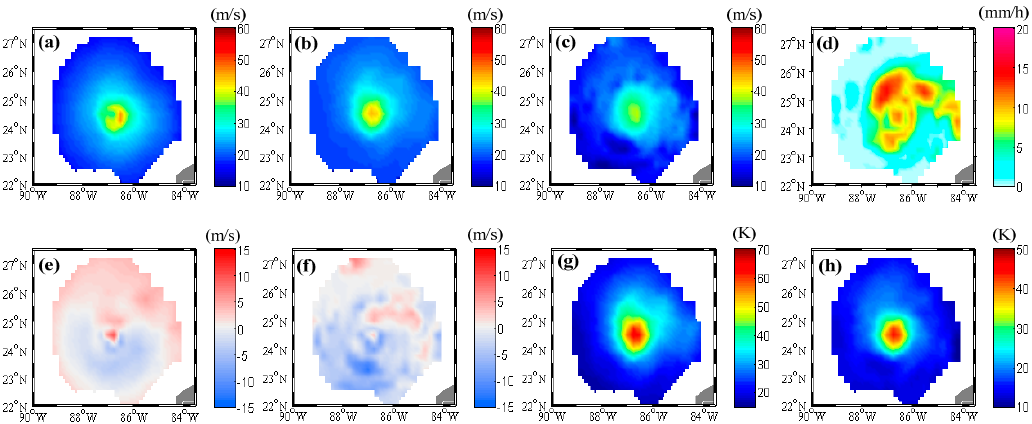
Figure 11. ( a ) H*wind wind speed for Rita on 22 September 2005, at 0130 UTC; ( b ) Retrieved wind speed based on our new model for Rita on 21 September 2005, at 2328 UTC; ( c ) RSS all-weather wind speed for Rita on 21 September 2005, at 2328 UTC; ( d ) RSS rain rate for Rita on 21 September 2005, at 2328 UTC; ( e ) The bias between H*wind and the wind speed retrieved with our new model; ( f ) The bias between H*wind and the RSS all-weather wind speed; ( g ) W6H over Rita on 21 September 2005, at 2328 UTC; ( h ) W6V over Rita on 21 September 2005, at 2328 UTC.